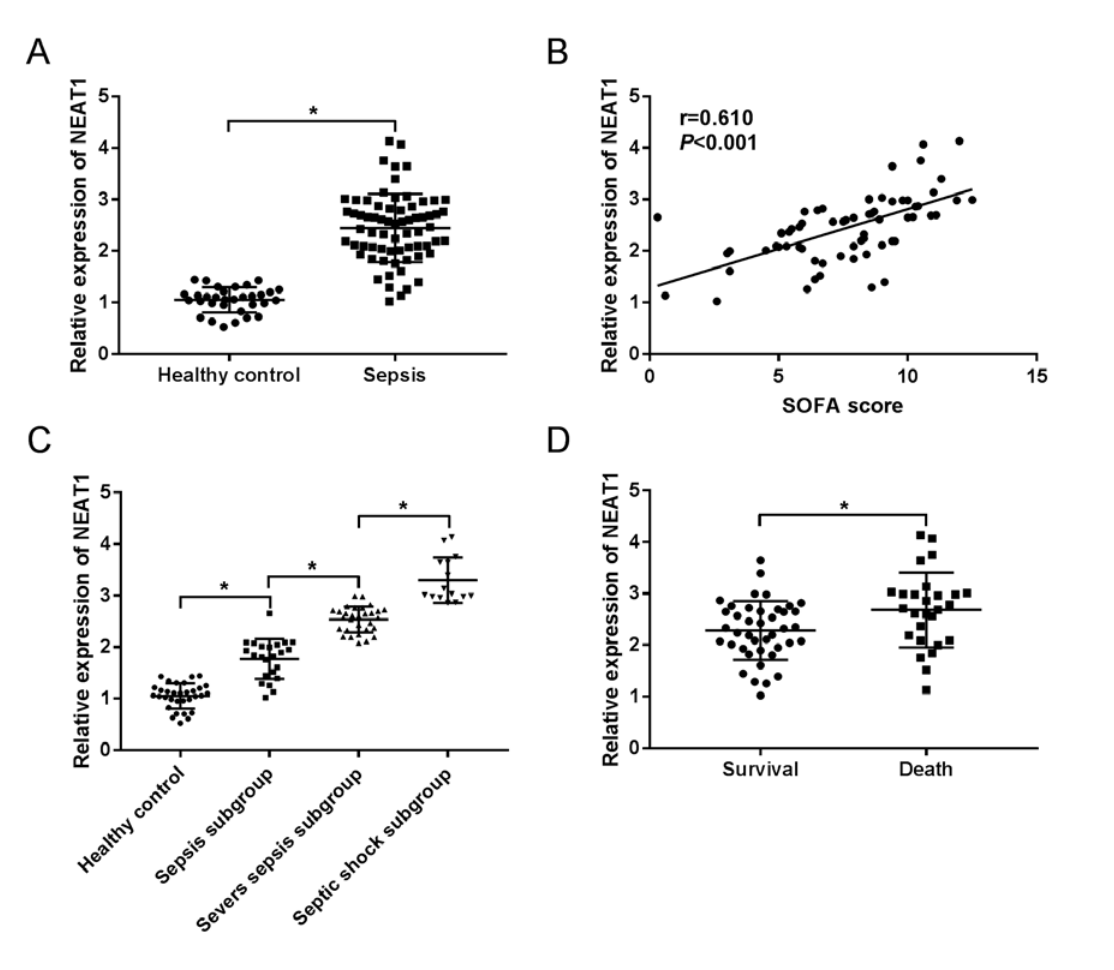
Figure 1: The expression of NEAT1 is increased in sepsis patients. (A) The expression of NEAT1 was measured in healthy control and sepsis samples by qRT-PCR. (B) The association between NEAT1 expression and patient SOFA score. (C) The level of NEAT1 was measured in healthy control and in patients with different severities of sepsis. (D) The abundance of NEAT1 was measured in survival or death group.